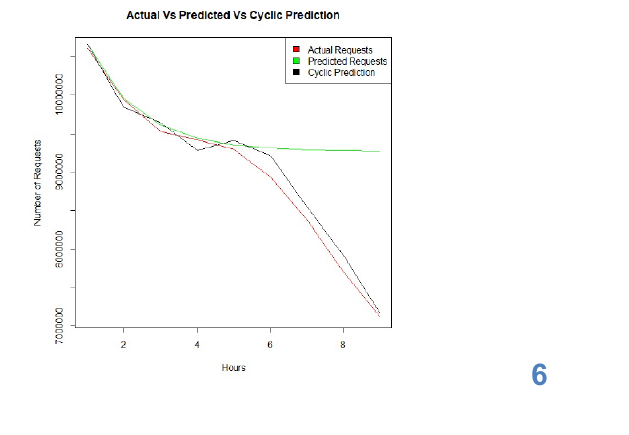
Figure 3. Actual VS OneTime VS Cyclic prediction